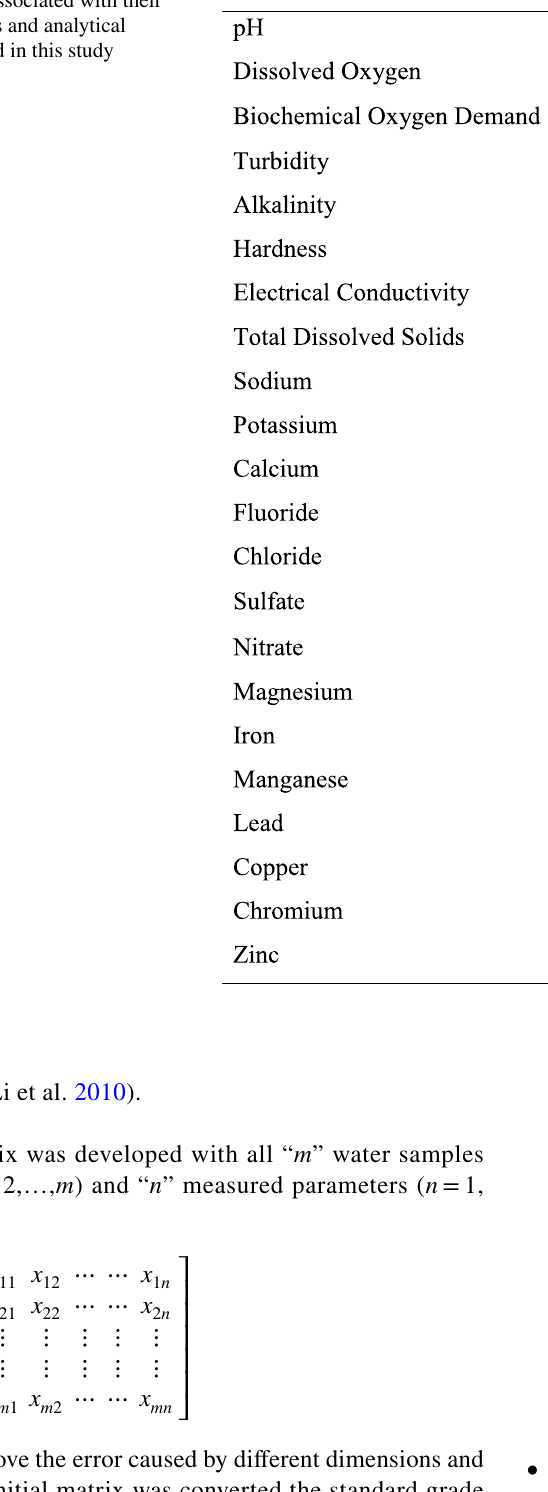
Table 1 Water quality parameters associated with their abbreviations and analytical methods used in this